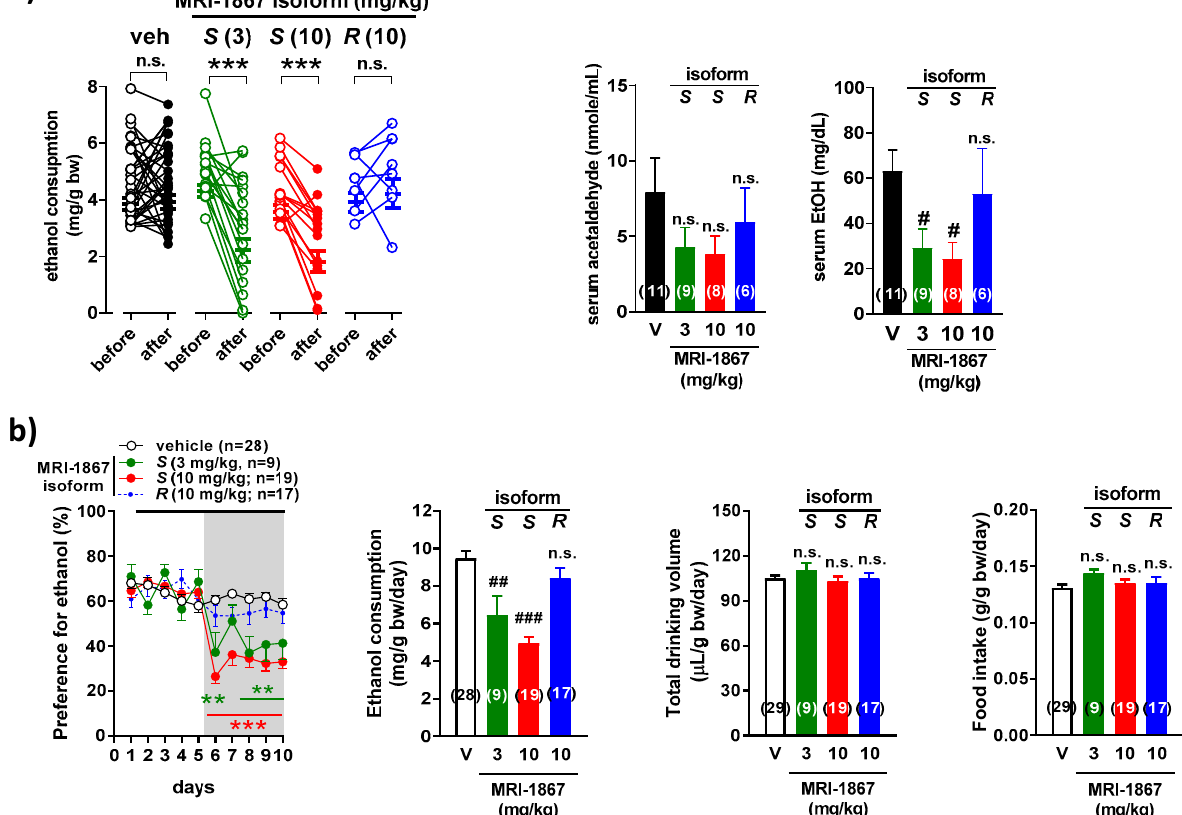
Figure 4. MRI-1867 decreases alcohol consumption after oral administration in two drinking models. ( a ) C57BL/6J mice had access to 20% ethanol for 4 h daily. On day 4, one hour before the dark period, mice received S -1867, (3, 10 mg/kg; S), R -MRI-1867 (10 mg/kg; R), or vehicle (V) by oral gavage and drinking session was repeated. Serum level of acetaldehyde and alcohol from blood obtained at the end of the drinking session. ( b ) Mice had free access to a 15% ethanol solution and water, using a two-bottle free-choice paradigm. From days 6 to 10, mice received daily S -MRI-1867 (3, 10 mg/kg; S), R -MRI-1867 (10 mg/kg; R), or vehicle (V) by oral gavage. Drinking behavior in individual animals ( a ) is expressed as points before (average of days 1–3) and after treatment (day 4). Other points and bars ( a , b ) are mean ± s.e.m. of daily to 5-day drinking behavior, respectively. ** p < 0.01, *** p < 0.001, compared with before treatment (Student’s t -test for paired samples) ( a ) or with vehicle (two-way ANOVA followed by Tukey’s multiple comparisons test) ( b ); # p < 0.05, ## p < 0.01, ### p < 0.001 compared to vehicle (one-way ANOVA followed by Dunnett’s post hoc test), n.s. not